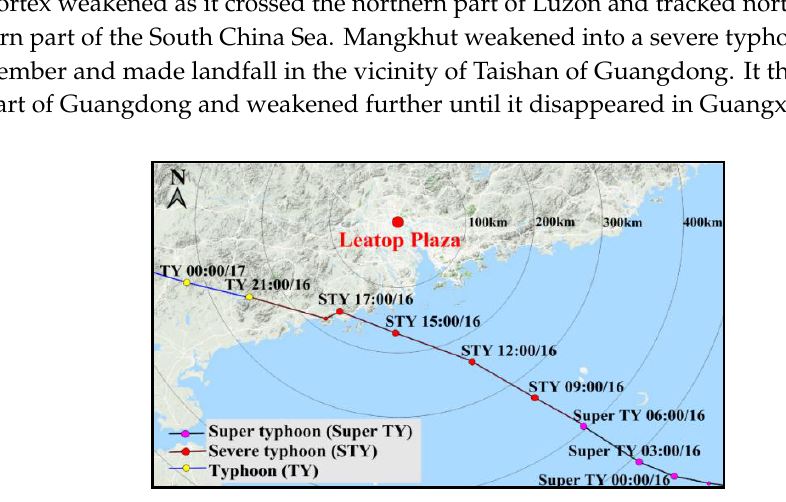
Figure 3. Best track of Typhoon Mangkhut and location of the study building.